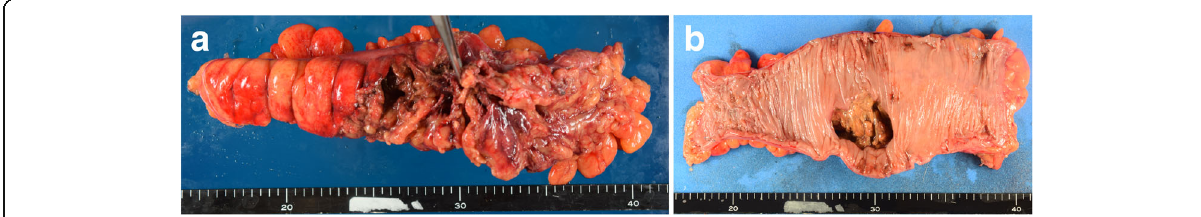
Fig. 2 Macroscopic appearance of the resected specimen. The surface of the serosal side showed edematous due to inflammation ( a ). The surface of the mucosal side shows a perforation of 4 cm in diameter. The mucosae around the perforation site are intact without ischemic change ( b